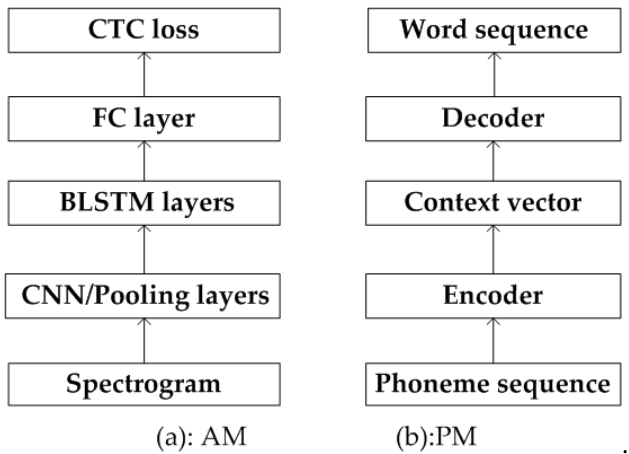
Figure 2. ( a ) Network of the AM; ( b ) Network of the PM. FC: fully connected; CTC: Connectionist Temporal Classification; BLSTM: bidirectional long-short term memory.